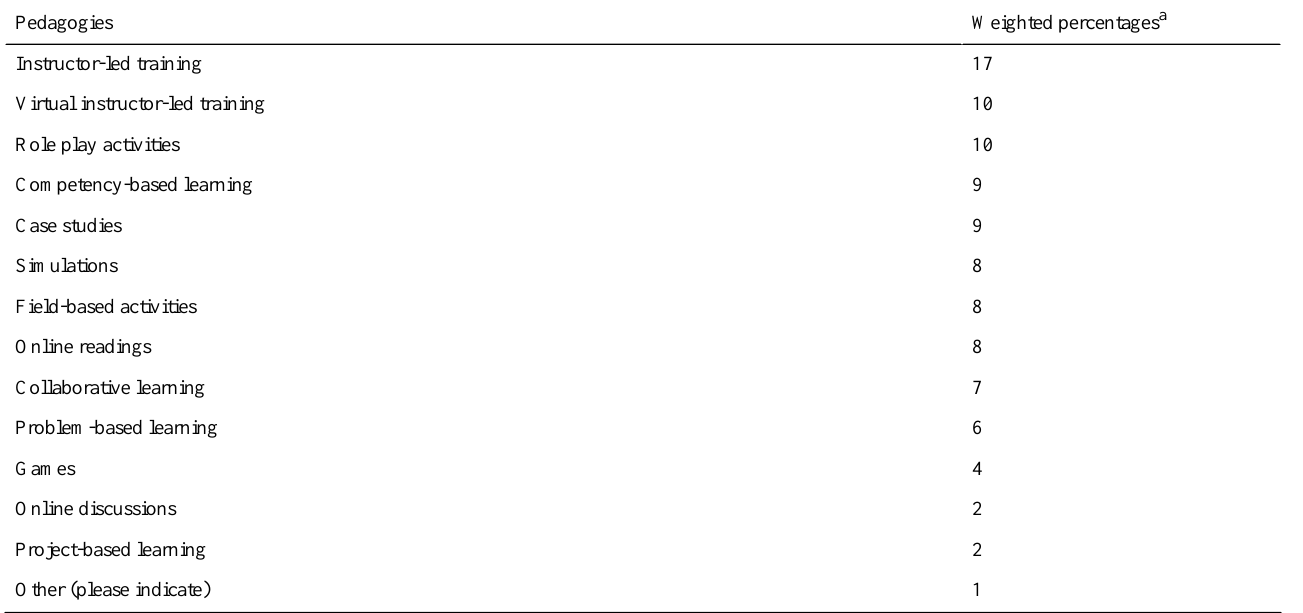
Table 3. Respondent-ranked importance of pedagogies.